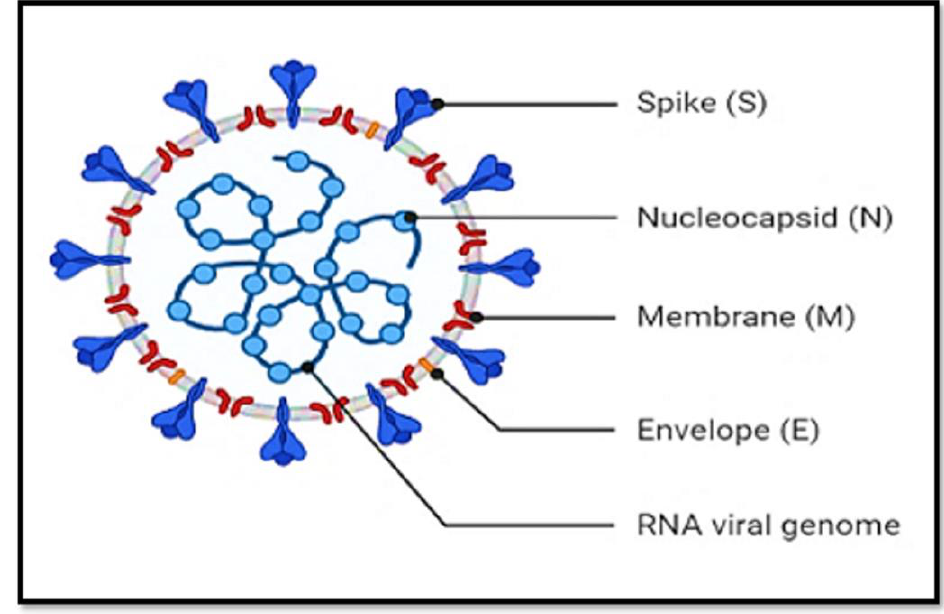
Figure 1. Structural representation of coronavirus 2019 (COVID-19).